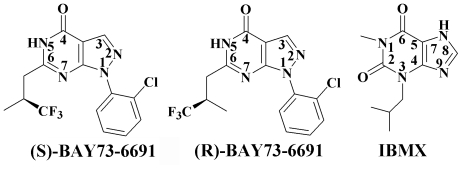
Chemical formulas of PDE9 inhibitors.1-(2-chlorophenyl)-6-(3,3,3-trifluoro-2-methylpropyl)-1H-pyrazolo [3,4-d]pyrimidin-4(5H)-one (BAY73-6691) and 3-isobutyl-1-methylxanthine (IBMX).